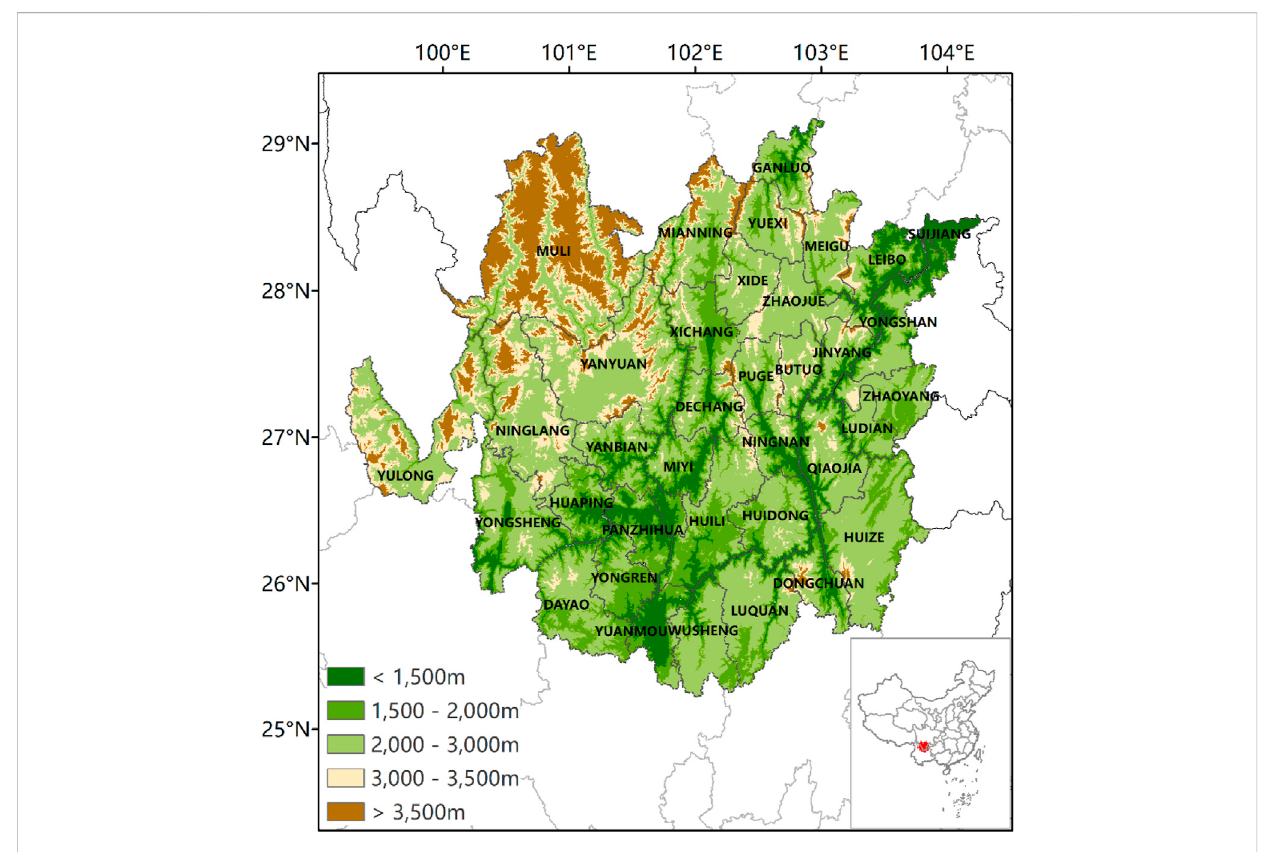
FIGURE 1 Topography and location of the study area.